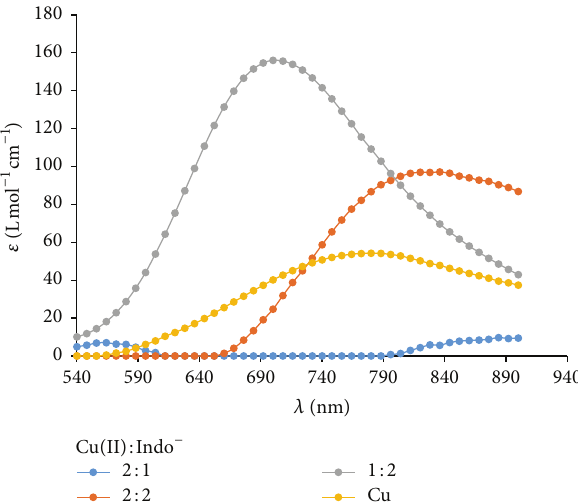
Figure 12: Molar absorptivity coefficients for the Cu(II)- Indomethacin complexes calculated by SQUAD.